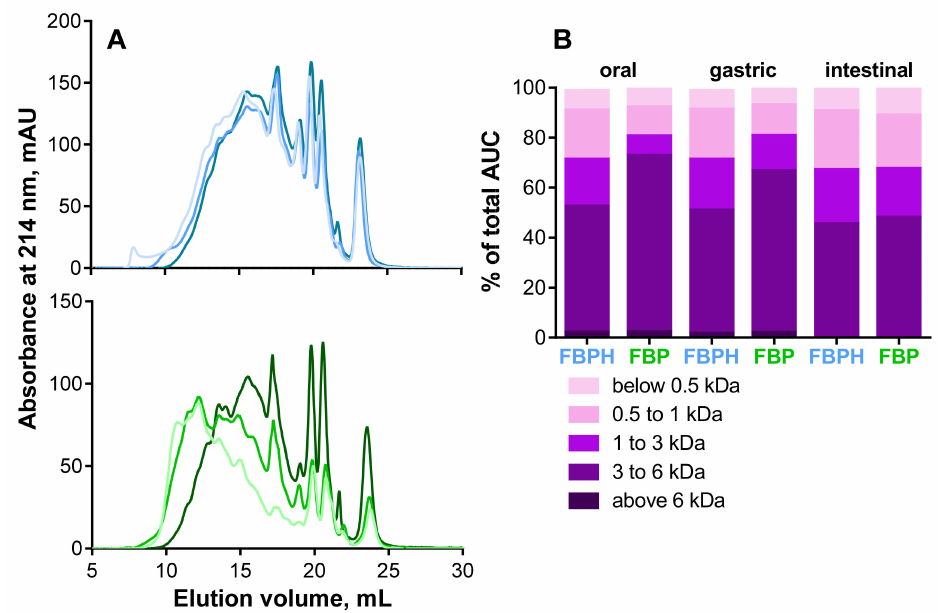
Figure 1. Peptide profiles and peptide molecular weight (MW) distributions. ( A ) Peptide profiles were obtained by size exclusion chromatography-fast protein liquid chromatography (SEC-FPLC): FBPH (blue curves), FBP (green curves); oral (light colored curves), gastric (colored curves) and intestinal (dark colored curves) digests. ( B ) The MW distribution of peptides in the different SGID compartments, expressed in percentage of total area under the curve (AUC), was calculated from the linear regression relationship which correlates the Log of known MW standard peptides and the elution